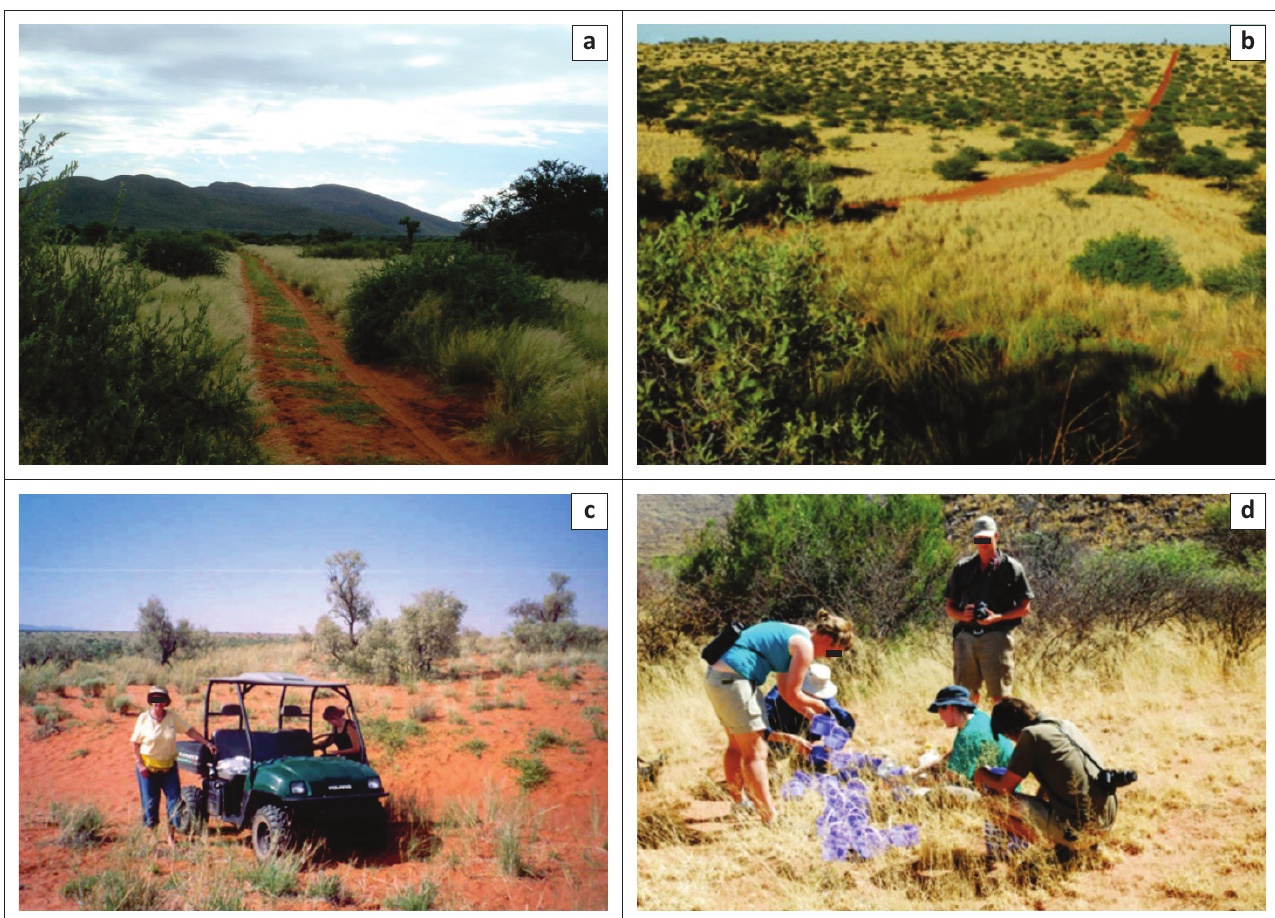
FIGURE 2: Habitat types in the Tswalu Kalahari Reserve: (a) Well-developed grass layer near the foothills of the Korannaberg Mountains; (b) Kalahari Thornveld; (c) Sand dune with poorly developed tree layer and moderately developed grass; and (d) One of the South African National Survey of Arachnida sampling sites. TABLE 1: Details of spider surveys undertaken at the Tswalu Kalahari Reserve during three field trips, including some of the authors of this article. Survey